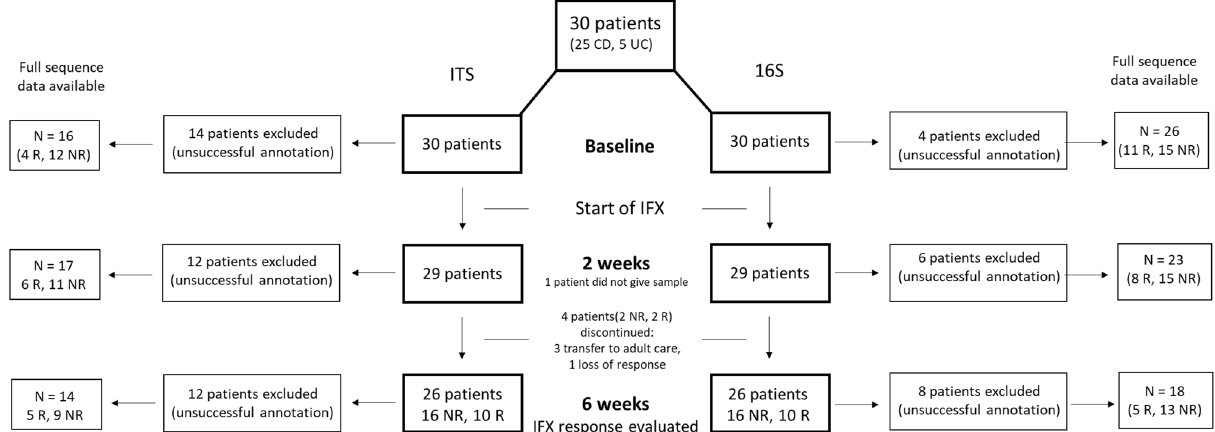
Figure 1. Overview of the study outline presenting the number of patients and samples at the three different timepoints (before start of treatment and 2- and 6 weeks post-treatment), response to infliximab (IFX) and reason of exclusion. R = responder, and NR = non-responder to IFX